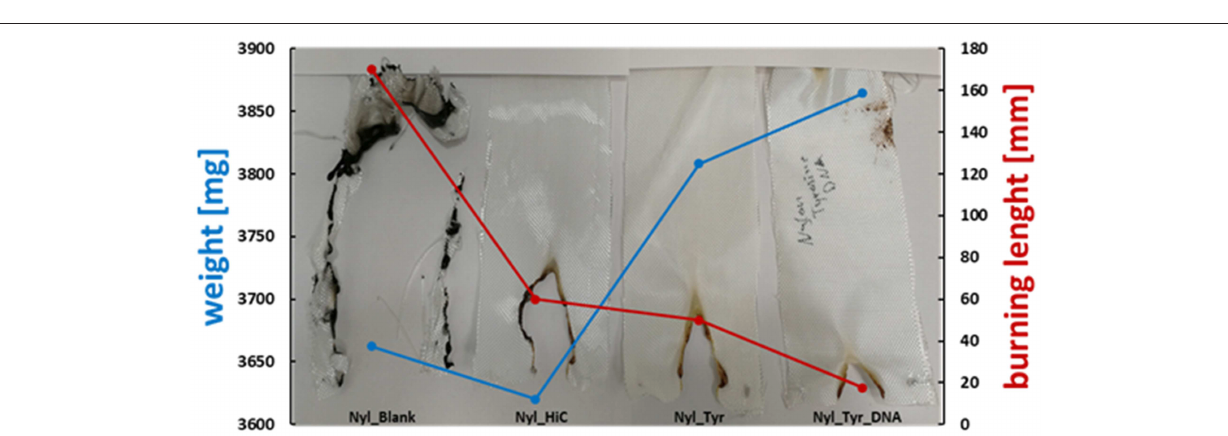
FIGURE 8 | Results of flammability tests of enzymatically activated and Tyrosine and Tyrosine/DNA treated nylon.